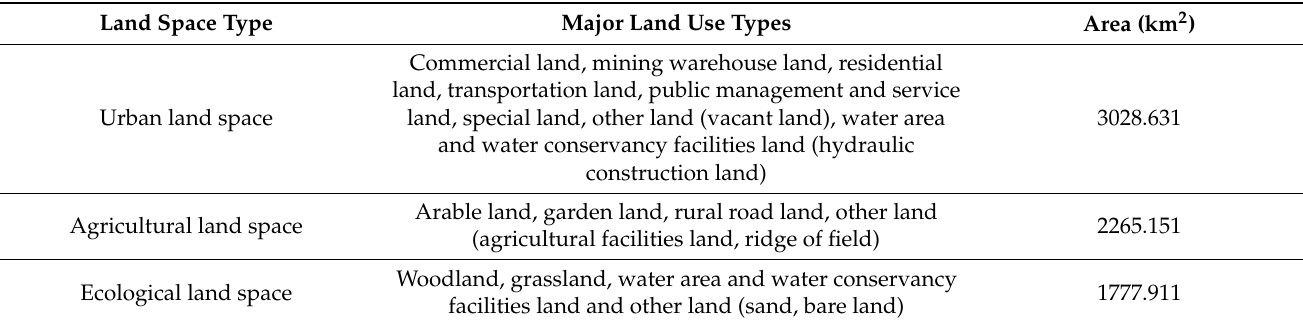
Table 3. The division scheme of land use space and area statistics.